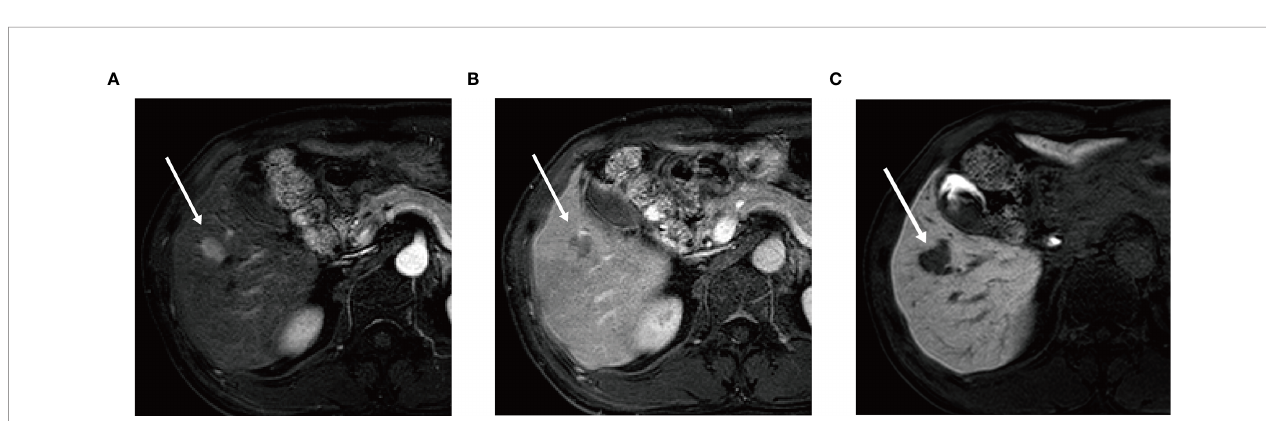
FIGURE 3 | Gadoxetic acid-enhanced MR image (A) in arterial phase shows a 2.0 cm × 1.6 cm nodular lesion with arterial enhancement in hepatic segment V (arrow) and this nodule shows washout (arrow) in the portal venous phase (B) . In hepatobiliary phase (C) the lesion shows wedge-shaped peritumoral hypointensity area (arrow).